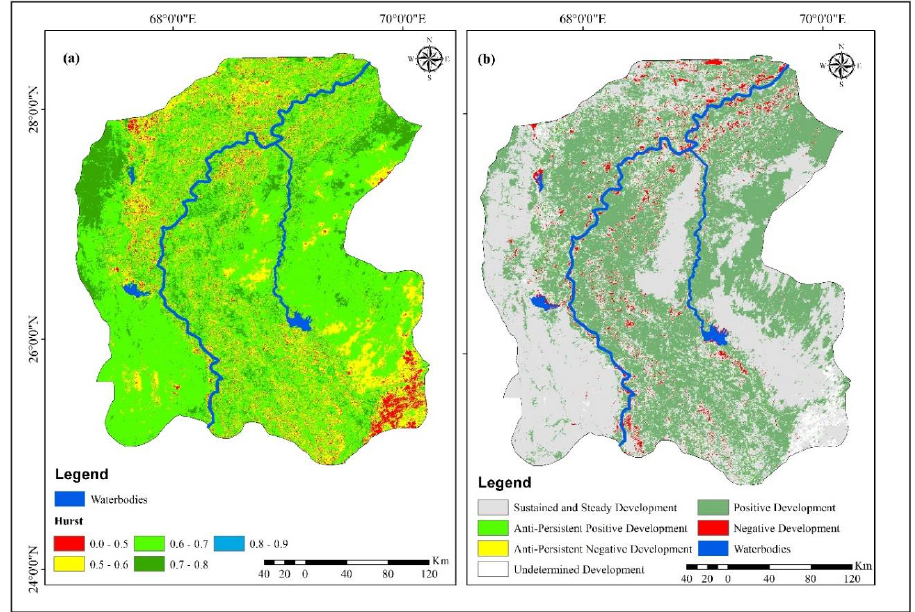
Figure 7. ( a ) Map of the Annual Hurst Exponent of the study area; ( b ) Annual Future vegetation trends based on H-value and vegetation dynamics (2000–2017).